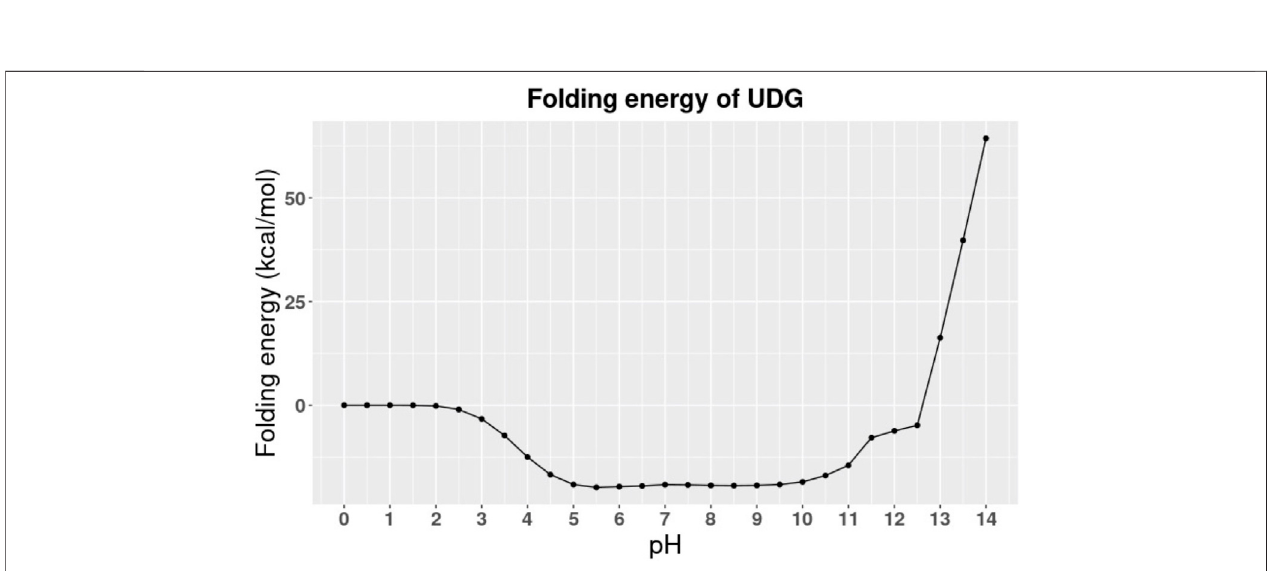
FIGURE 1 | DNA/UDG complex structure. (A) The overall structure of UDG (gray) and a double-stranded DNA of which the uracil (at B5 location) fl ips out to the pocket. (B) A zoom-in view of the binding area of UDG (gray) and the uracil (at B5 location).